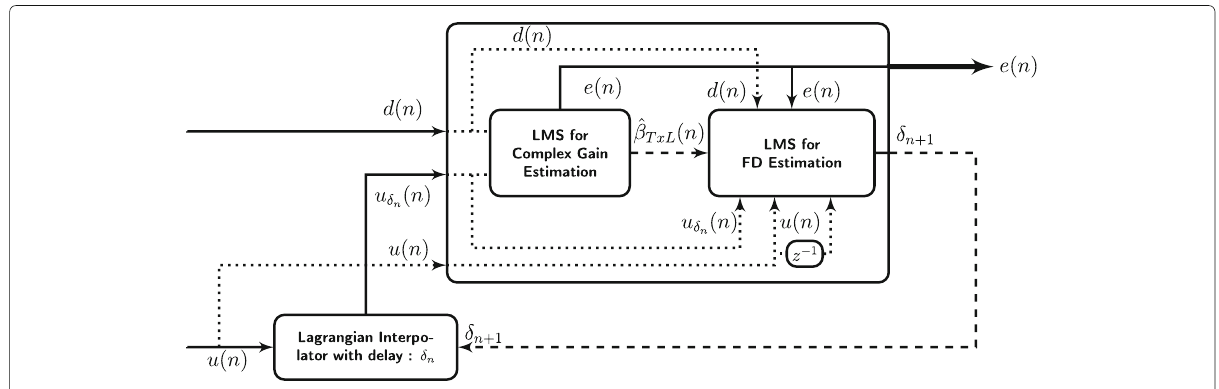
Fig. 2 Joint estimation framework for the TxL compensation